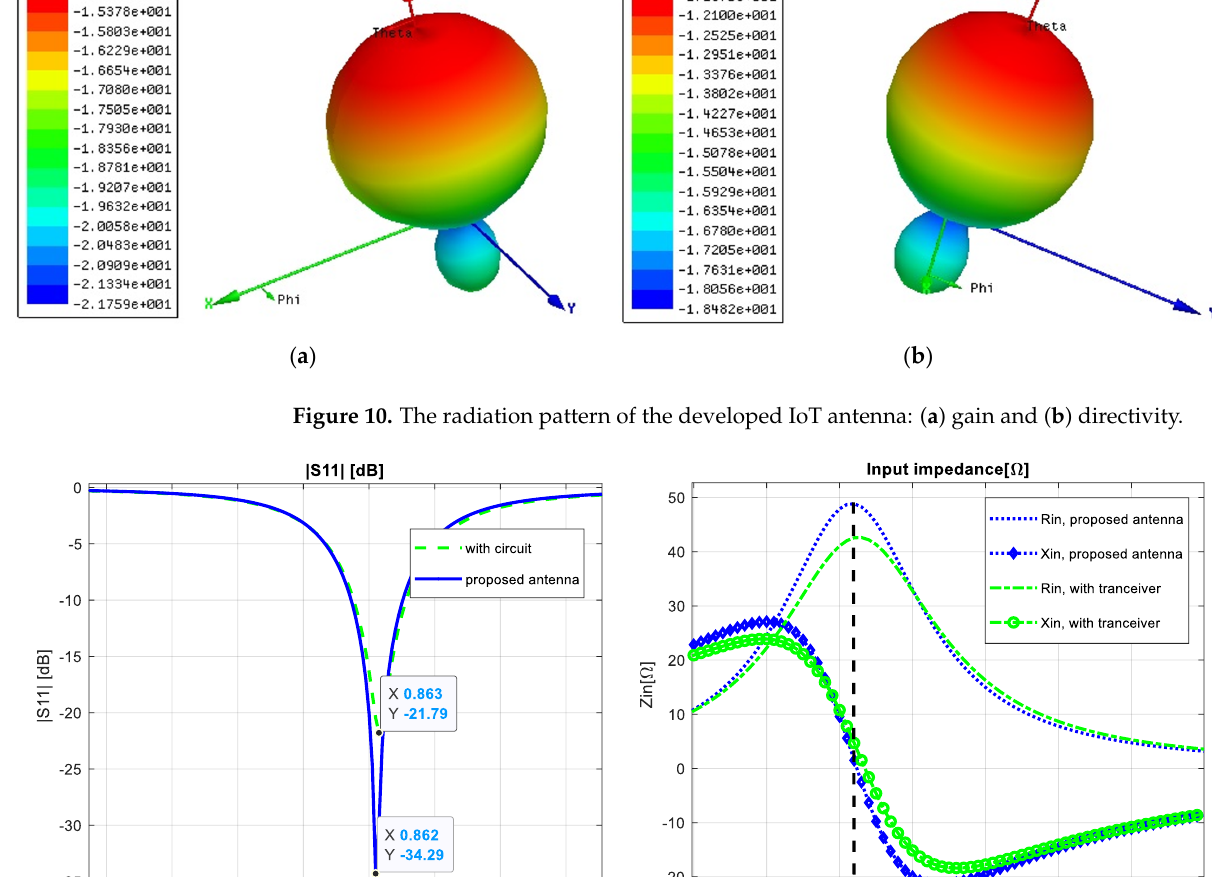
Figure 10. The radiation pattern of the developed IoT antenna: ( a ) gain and ( b ) directivity.